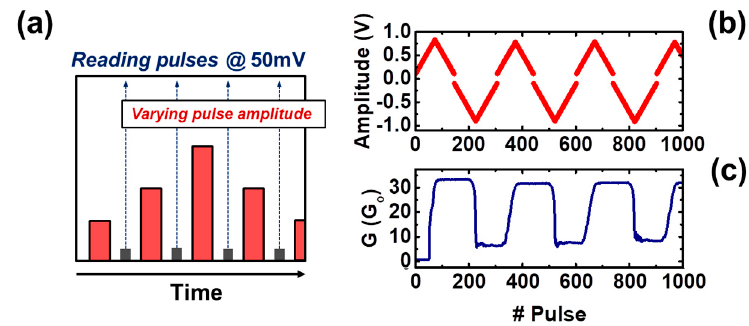
Figure 5. ( a ) Stair-case pulse-programming scheme used in [29] for obtaining the G–V characteristics of a memristive device. ( b ) The pulse amplitude was increased and decreased over time to change the device conductivity. ( c ) Conductivity G as a function of the applied pulses.